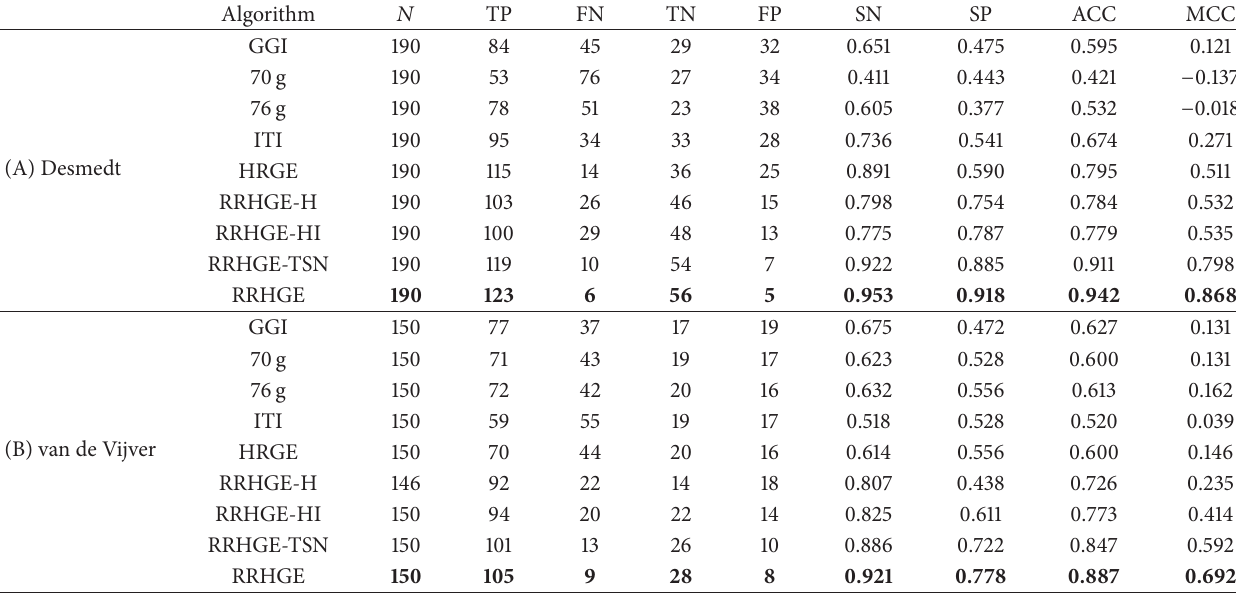
Table 4: Classification results of the RRHGE gene signature and other existing gene signatures on two testing sets, for example, (A) the Desmedt dataset and (B) the van de Vijver dataset.